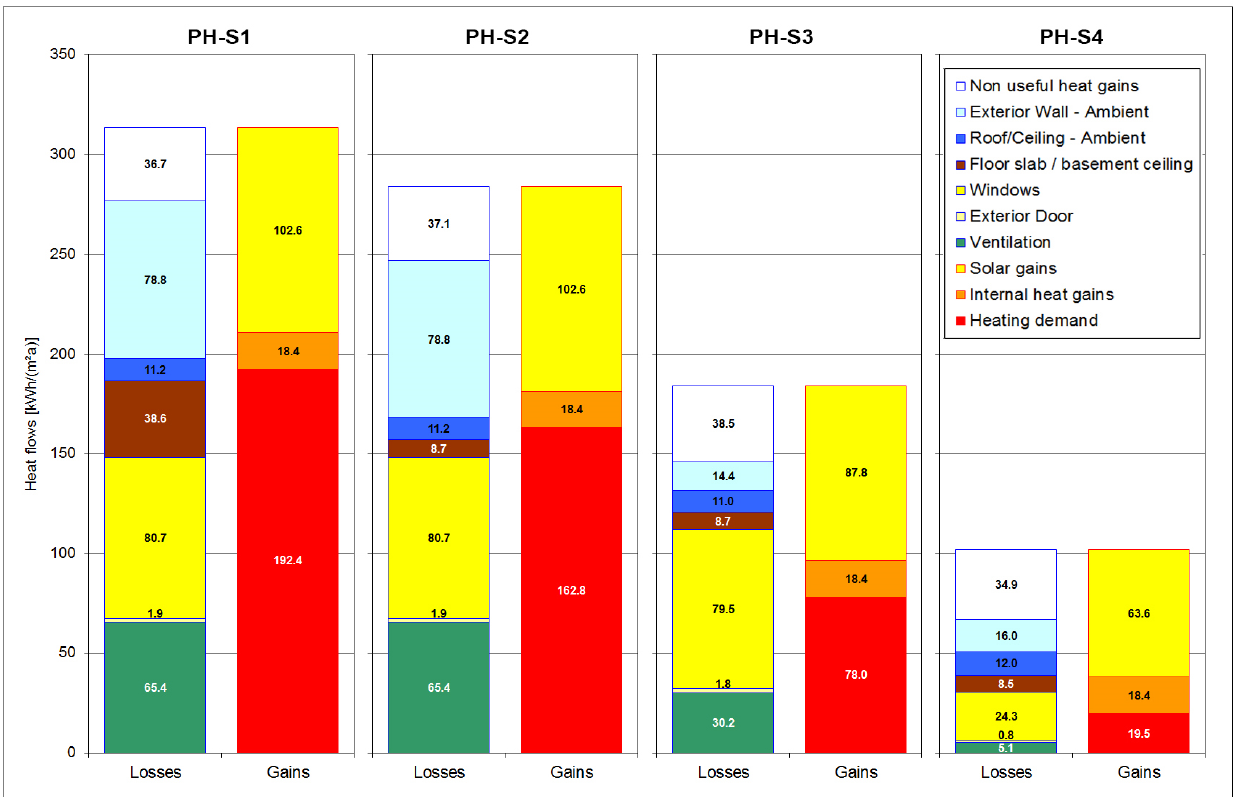
Figure 6. Comparison of heat flows (losses and gains) of the four incremental retrofit packages to meet the EnerPHit standard calculated with